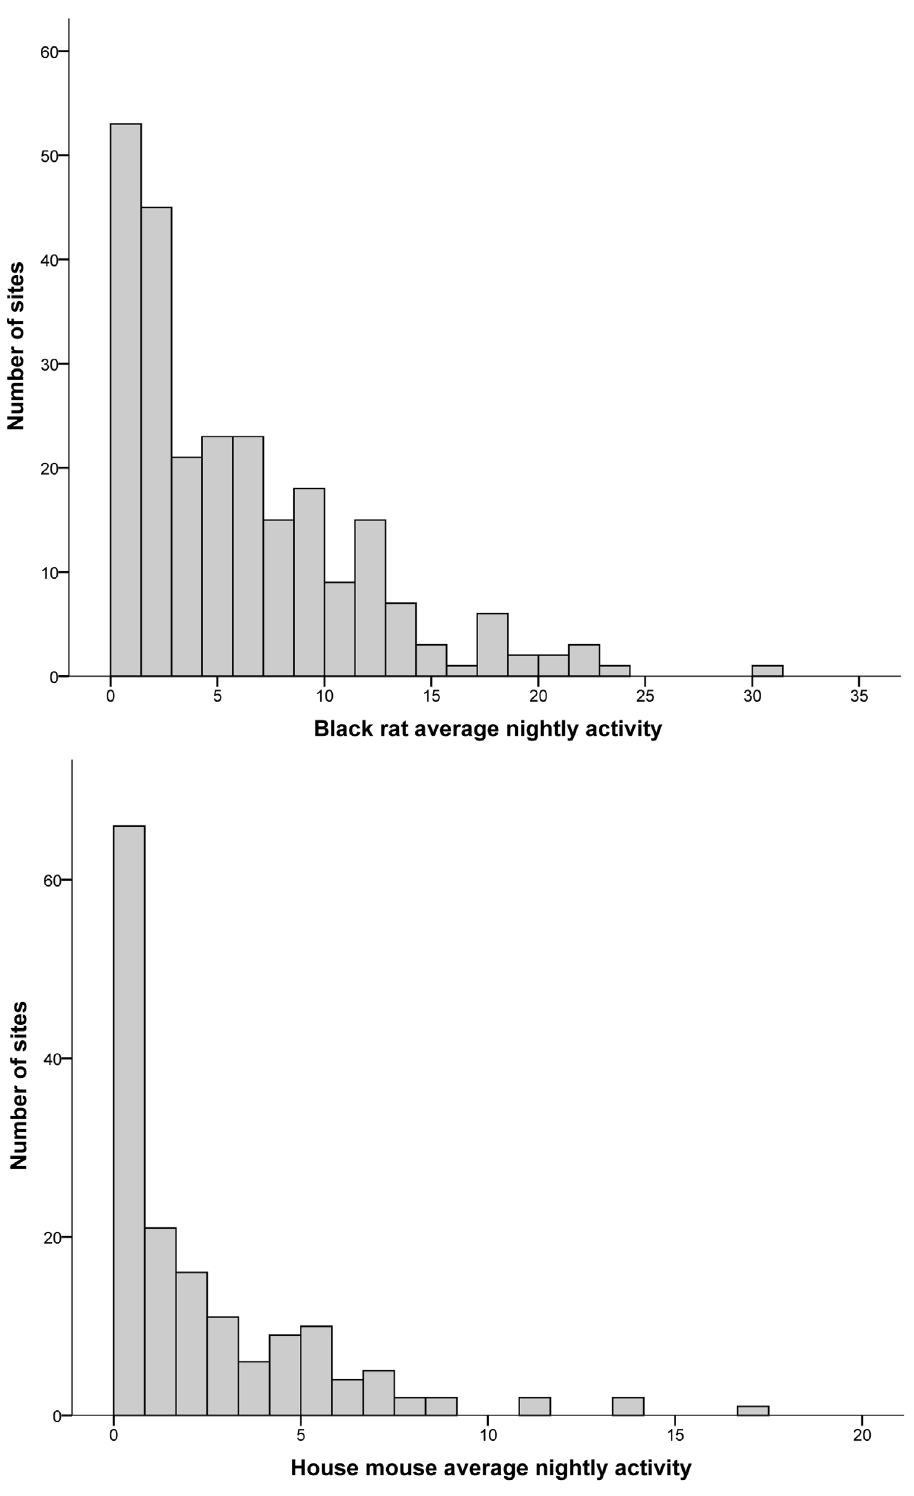
Figure 3. Histogram demonstrating the variation levels in the activity index derived from camera trapping. The number of sites at which activity index measures (mean number of events per night) were observed for black rats (a) and house mice (b). doi:10.1371/journal.pone.0086592.g003 were visually estimated. The remaining cover categorised as four in each corner of the quadrat, and four more 1 m either side ‘other’. Structural complexity of habitats at each site was measured of the camera. For each measurement, the number of touches of using a 1 m high structure pole [41] at eight points at each site, vegetation within each 100 mm interval (maximum ten touches) to